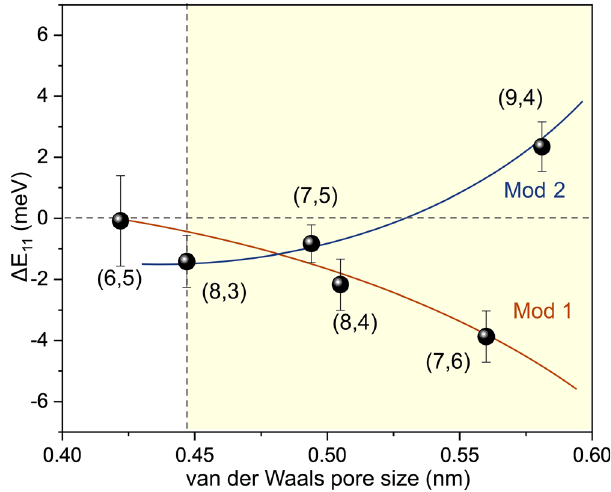
Fig. 3 Molecular fi lling of nanotube pores is size dependent. The PL energy differences between cyclohexane (99.9%)- and n-hexane-incubated end-opened SWCNTs ( Δ E 11 = E 11,cyclohexane – E 11,n-hexane ) obtained from experiments are plotted as a function of the van der Waals pore size of the nanotubes. Both n-hexane and cyclohexane can fi t in those nanotube pores in the yellow colored area, while only n-hexane can enter the (6,5)-SWCNT pore, suggesting the existence of a threshold pore size below which n- hexane can enter but cyclohexane cannot. Note that the curves are added to guide the eye. The curves connect nanotubes of Mod 1, with mod( n − m , 3) = 1, and Mod 2 (mod( n − m , 3) = 2). The error bars represent the standard deviation of the E 11 emission peak position measured from multiple different SWCNT samples. Uncertainty in the calculated points are represented by error bars equal to one standard